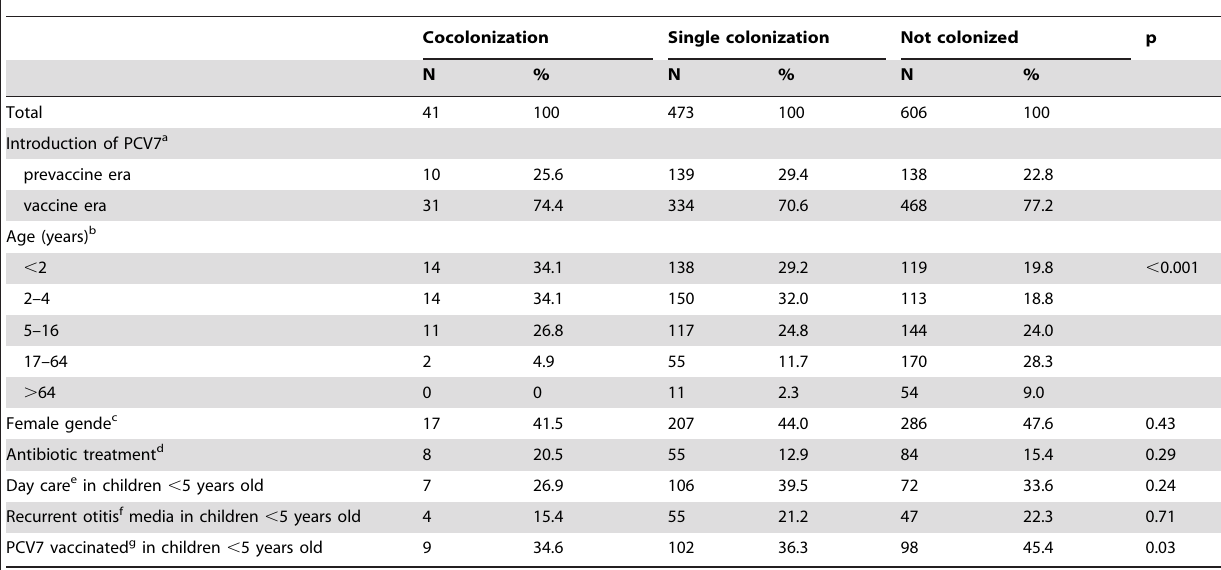
Table 1. Univariate analysis for factors associated with carriage of single or multiple strains of Streptococcus pneumoniae .